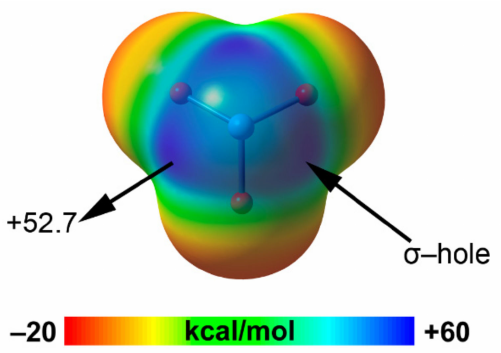
Figure 22. MEP surface (0.001 a.u.) of XeO 3 (MP2/def2-TZVP). MEP energy at the selected point is given in kcal/mol.